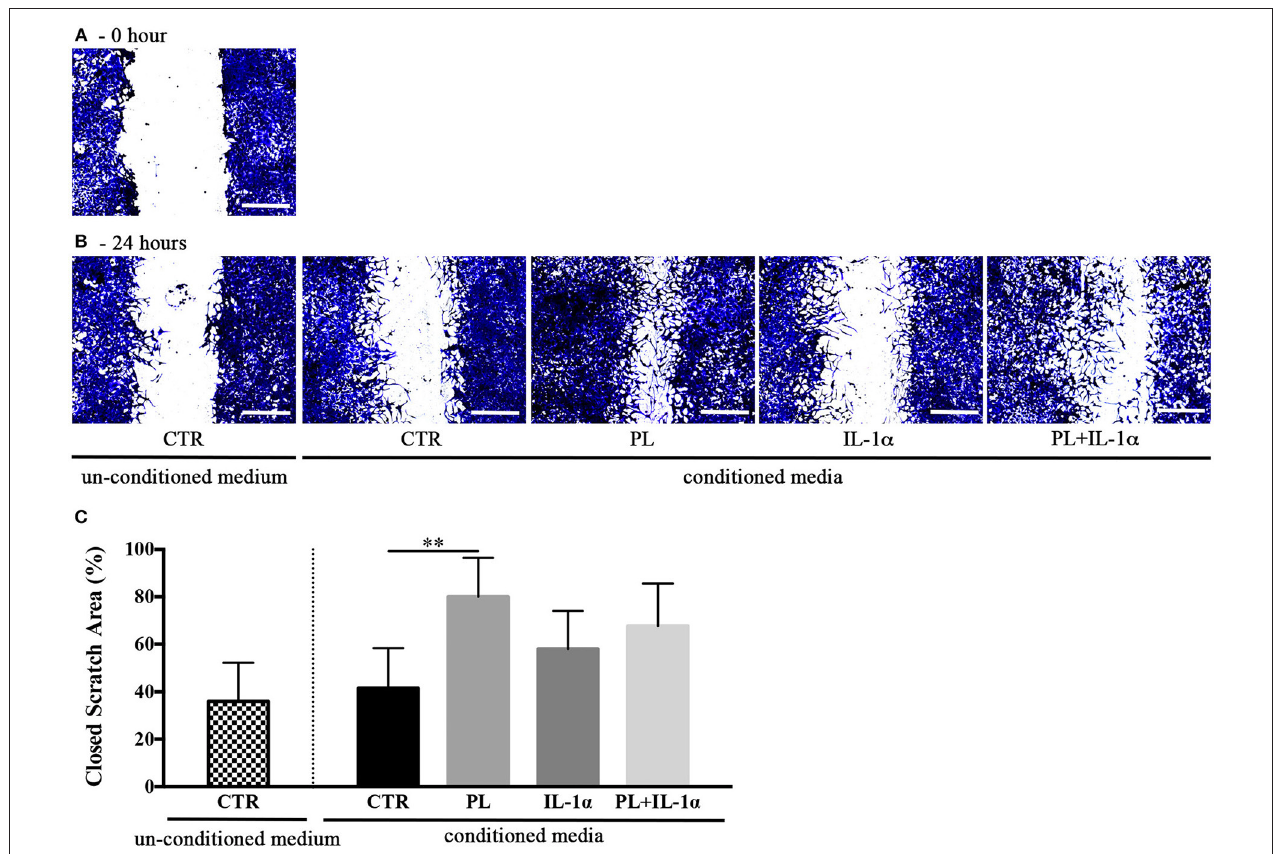
FIGURE 7 | Effect of hASC-conditioned media, collected 24h after 24-h PL stimulation in presence or absence of IL-1 α , on keratinocyte migration evaluated by an in vitro scratch assay. (A,B) Representative images of scratched confluent cell monolayers incubated with 75%-diluted hASC-conditioned media for 0 (A) and 24h (B) (scale bars = 300 µ m). CTR refers to serum-free medium. Supplemented and un-supplemented conditioned media were collected 24h after a previous 24-h serum deprivation; (C) “Closed scratch area” calculated by TScratch software at the end of incubation in all tested conditions. Average values ± SD of 3 independent experiments, each one performed in triplicate. The ** symbol corresponds to p =